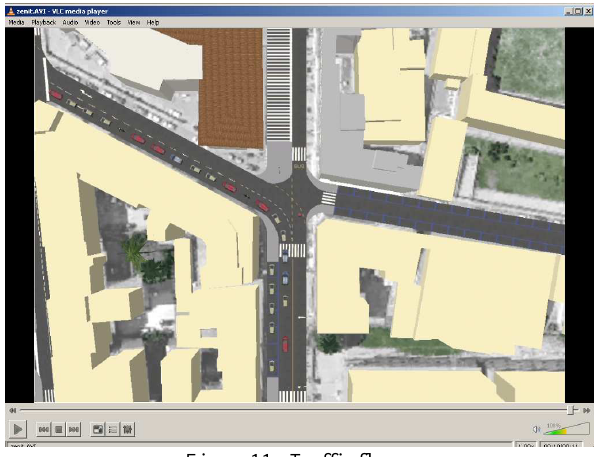
Figure 11. Traffic